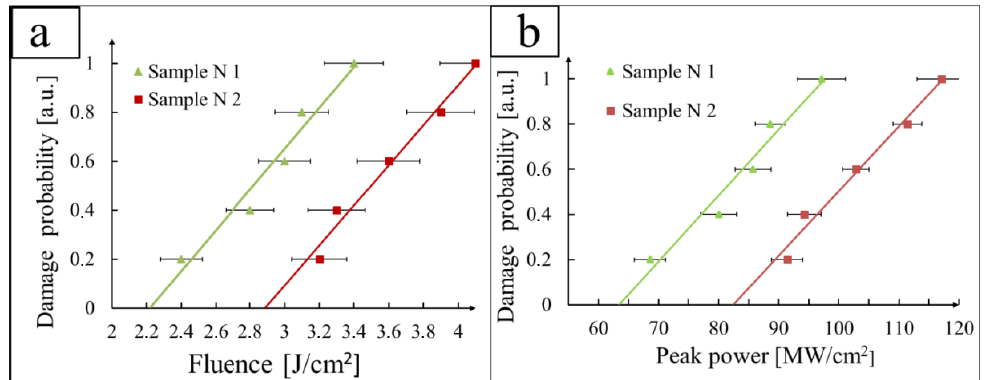
Figure 7. Dependence of the optical breakdown probability of samples No. 1 and No. 2 on the energy density of the incident laser radiation—( a ); and on the power density of the incident laser radiation—( b